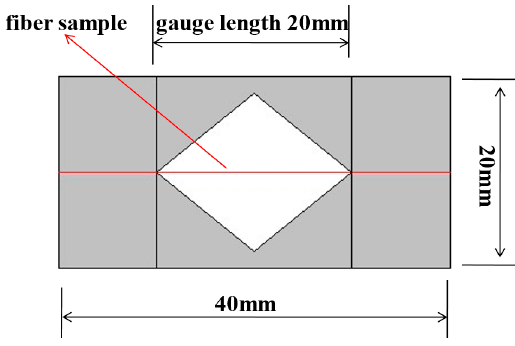
Figure 3. Schematic diagram of the tensile sample.